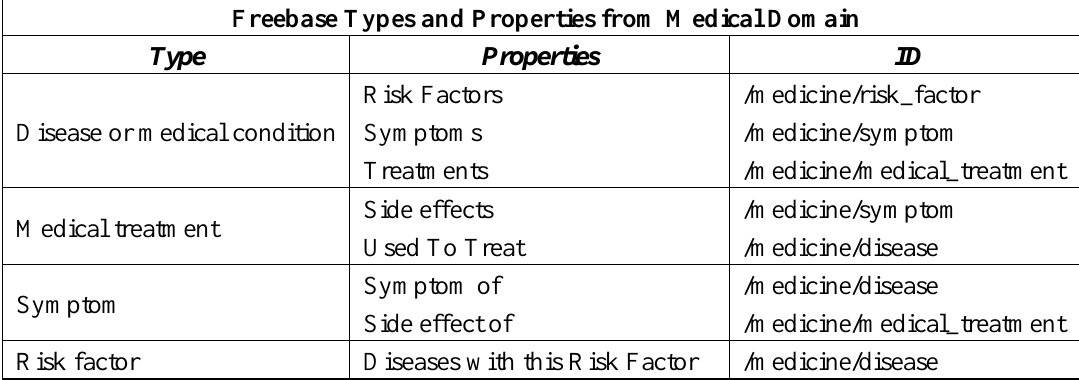
Table 1. Selected freebase types and properties.